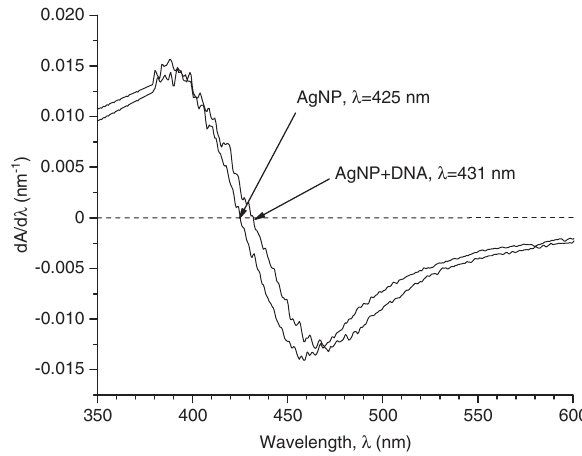
Figure 3 First derivative of absorption spectra of AgNPs and AgNPs-DNA. The blue shift is